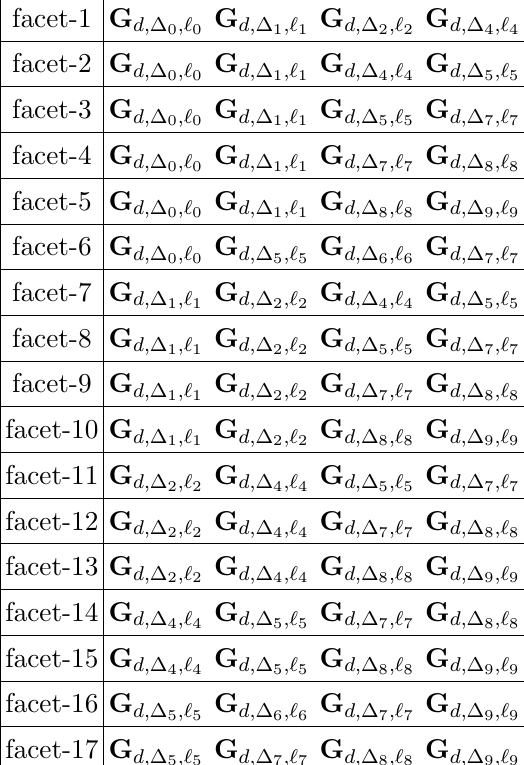
Table 6. Various facets for D = 2 N = 4 for 2d ising model, where G d; (cid:1) for D = 2 N = 4 and G d; (cid:1)